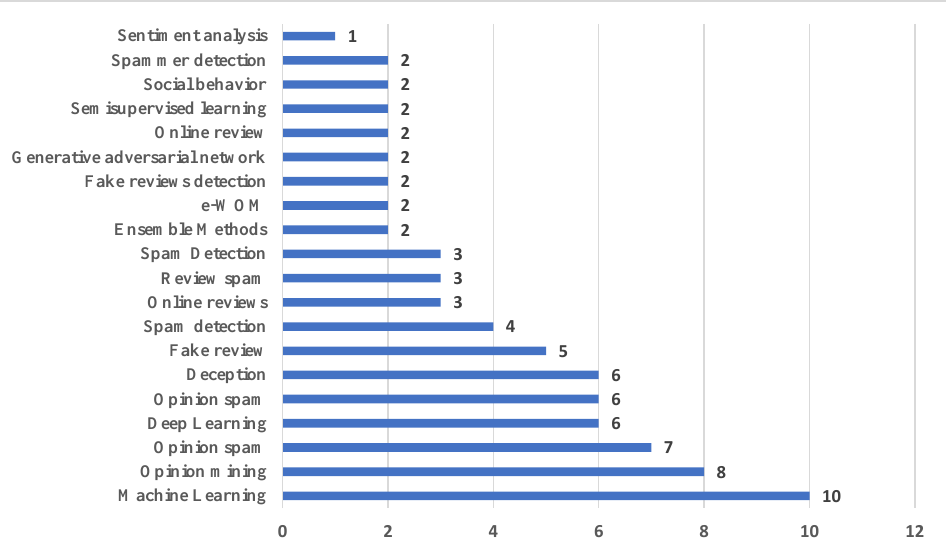
Figure 7. The most keywords appearance form the reviewed